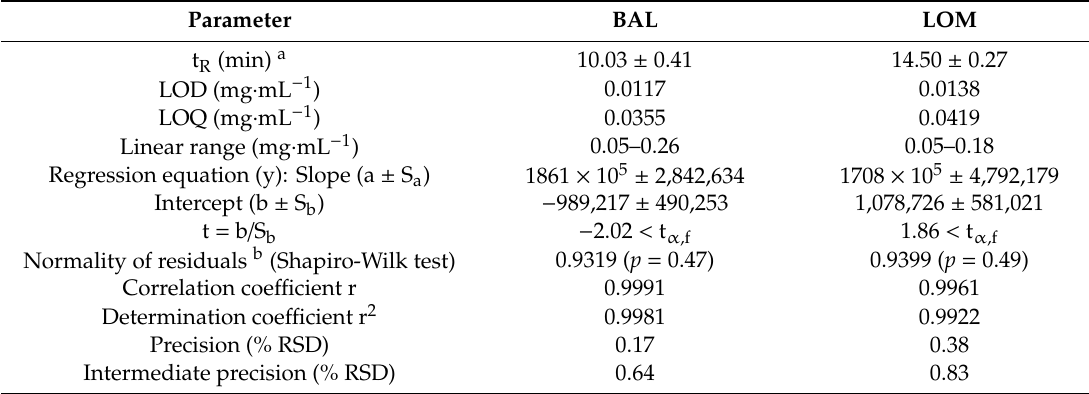
Table 1. Validation of the method.